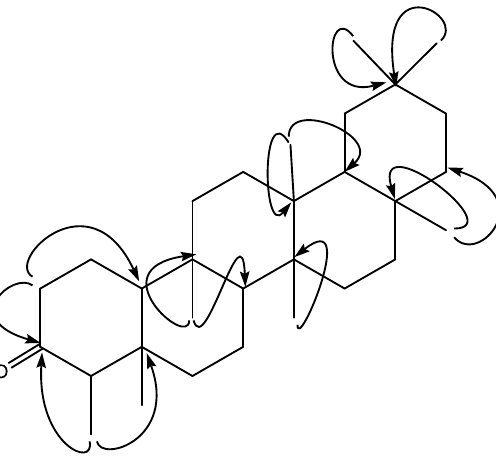
Figure 2. Key HMBC correlations of friedelin ( 1 ).